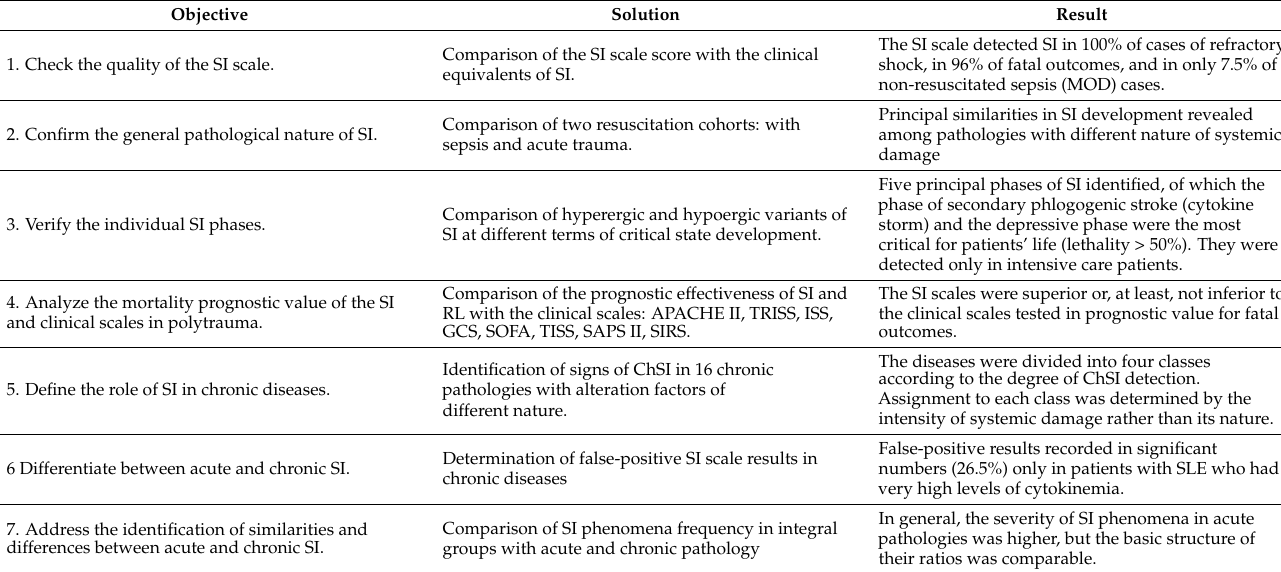
Figure 6. The frequency of the phenomena detected in the integral groups of patients with acute and chronic SI. Note. *—significant difference (Chi-square test, p < 0.05); SIR—systemic inflammatory response (RL > 0); DIC—disseminated intravascular coagulation; HPA—hypothalamic-pituitary- adrenal system; SI—systemic inflammation; ChSI—chronic systemic